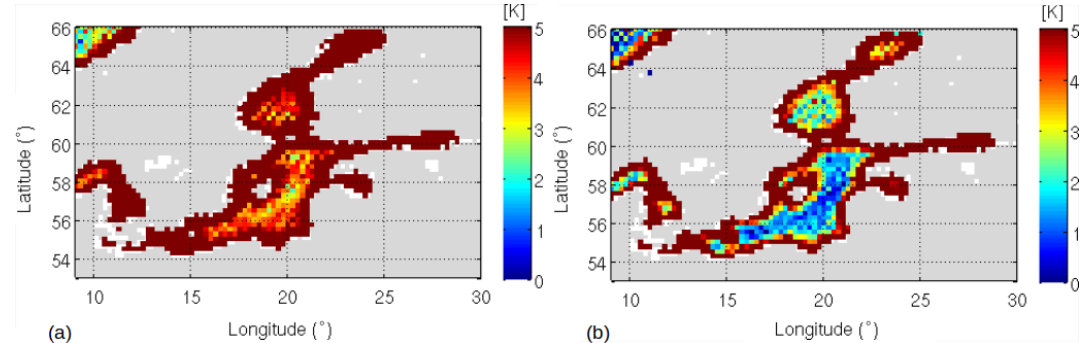
Figure 2. A 9d 0 . 25 ◦ map (June 2014) of the mean anomaly (TB SMOS − TB mod ) of the first Stokes parameter divided by two, that is, the average between the horizontal and vertical polarizations of the TB ((TB H + TB V ) / 2) [K]. (a) TB without the G kj correction, (b) TB after applying the G kj